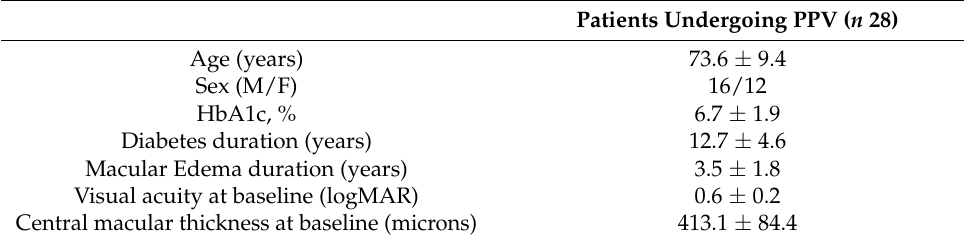
Table 1. Baseline characteristics of the study groups.